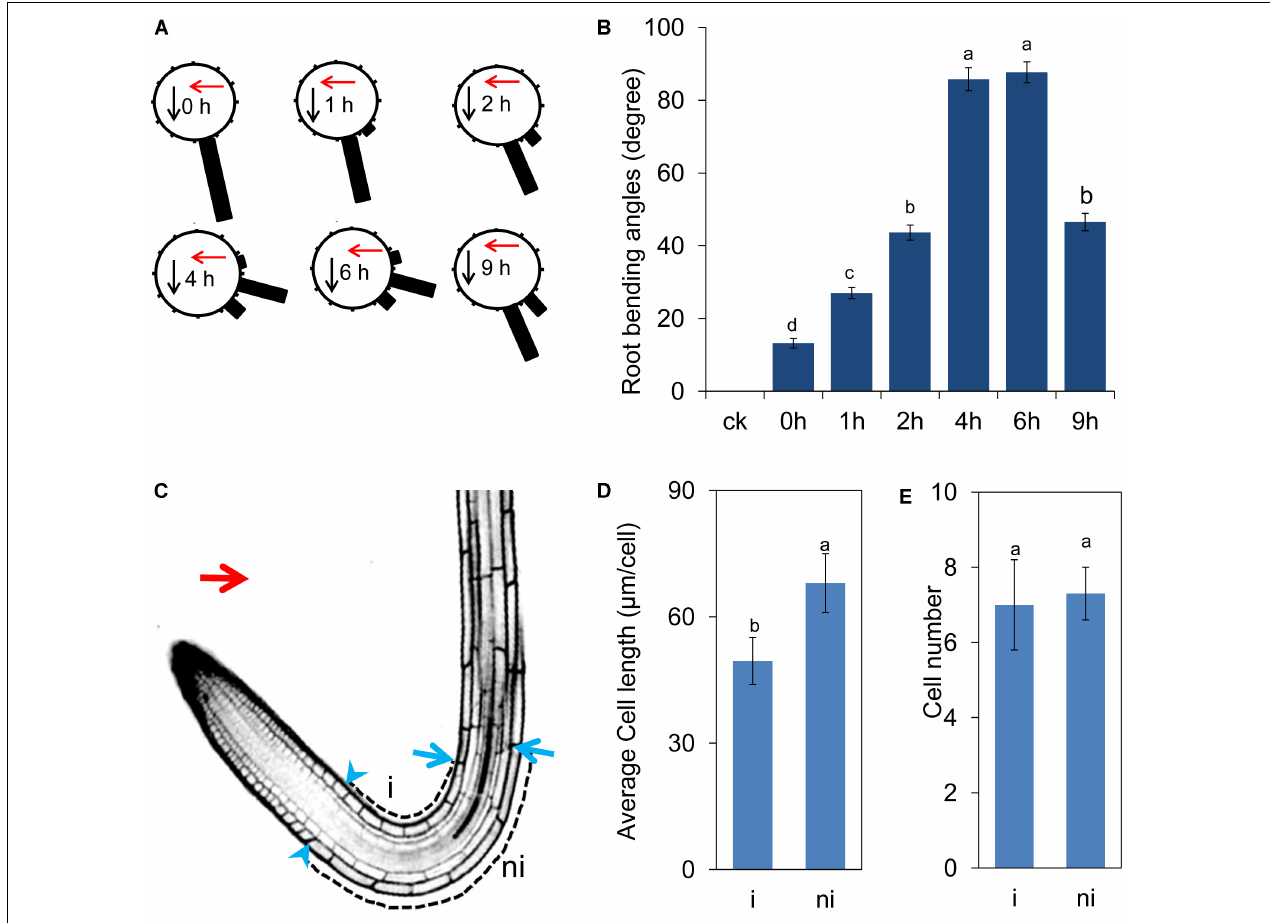
FIGURE 1 | UV-B radiation induces root bending. Five-d-old Arabidopsis seedlings grew on vertical plates, irradiated with UV-B for 1 h and then transferred to normal growth conditions for another 9 h. (A , B) The angle of root bending was measured after 0–9 h of treatment, n = 60. The red arrow indicates the direction of UV-B-radiation. (A) Each gravistimulated root was assigned to 1 of the 12 30 ◦ sectors on a gravitropism diagram. The length of each bar represents the mean percentage of seedlings assigned to the respective sector. The red and black arrows indicate the direction of UV-B radiation and gravity, respectively. (B) The average root bending angles; ck, before UV-B radiation control. (C–E) UV-B represses cell elongation during UV-B-mediated phototropic response of Col-0 roots (C) . The blue arrowheads and arrows represent the last meristematic cells and the cells where the turn initiated in the illuminated (i) and nonilluminated (ni) sides, respectively. The red arrow indicates the direction of UV-B radiation. The average cell length (D) and number of cells (E) in illuminated (i) and nonilluminated (ni) sides. The error bars represent the ± SE, and different letters indicate significantly different values ( P < 0.01 by Tukey’s